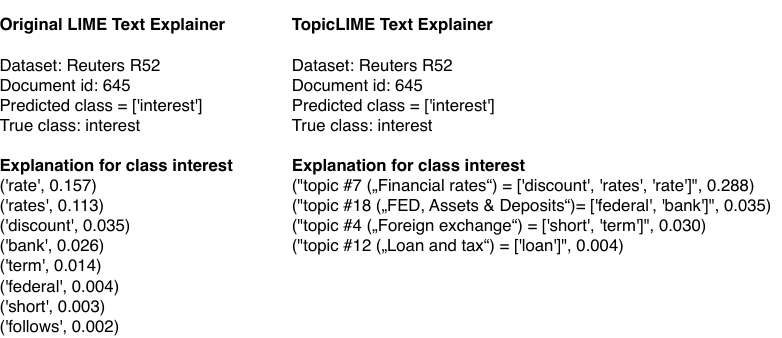
Figure 2. Textual comparison of original LIME text explainer ( left ) and topicLIME text explainer ( right ). A contextual interpretation of the word-explanations generated by LIME is complicated as the semantic “links” of a word are not reflected in the explanations. For topicLIME explanations, coherent and most likely, at least semantically, related words are considered at once including the semantic “links” that in turn provide the context in the